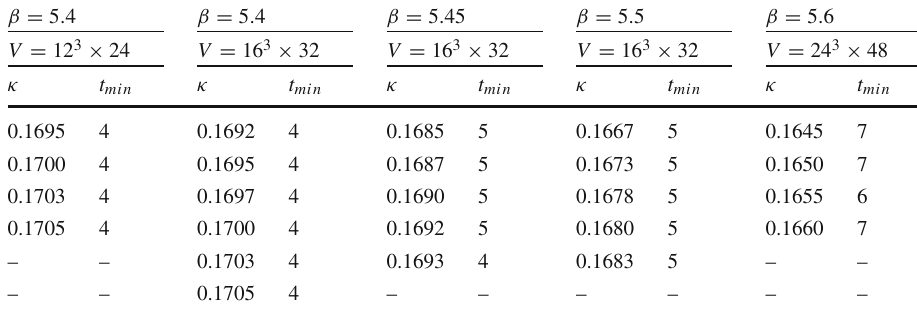
β = 5 . 4 β = 5 . 4 β = 5 . 45 β = 5 . 5